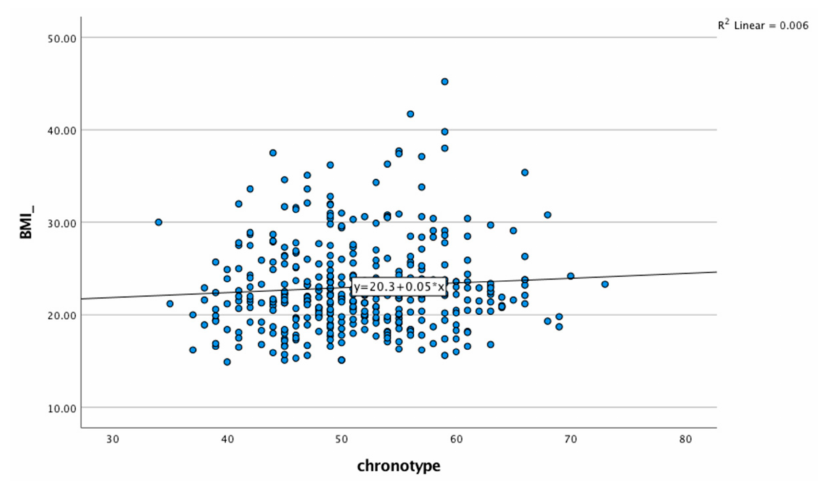
Figure 2. Linear regression analyses between chronotypes and BMI